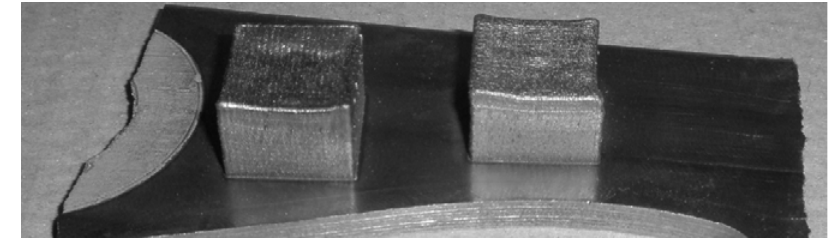
Figure 1. “Parts before end finishing (80x80x60 mm)”. Source: authors.